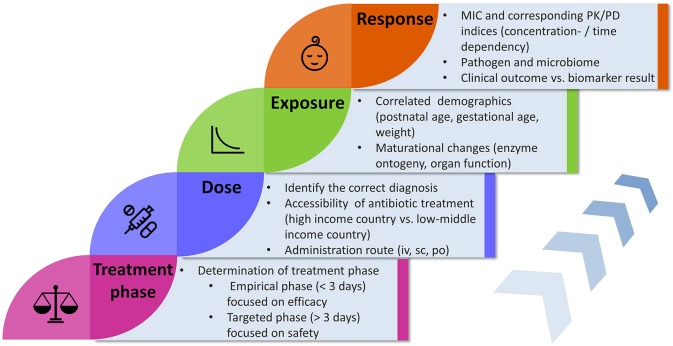
Flowchart illustrating key components and factors influencing the concepts concerning antibiotic treatment in neonates and infants. MIC, minimal inhibitory concentration; PK, pharmacokinetics; PD, pharmacodynamics; iv, intravenous; sc, subcutaneous; po, oral.